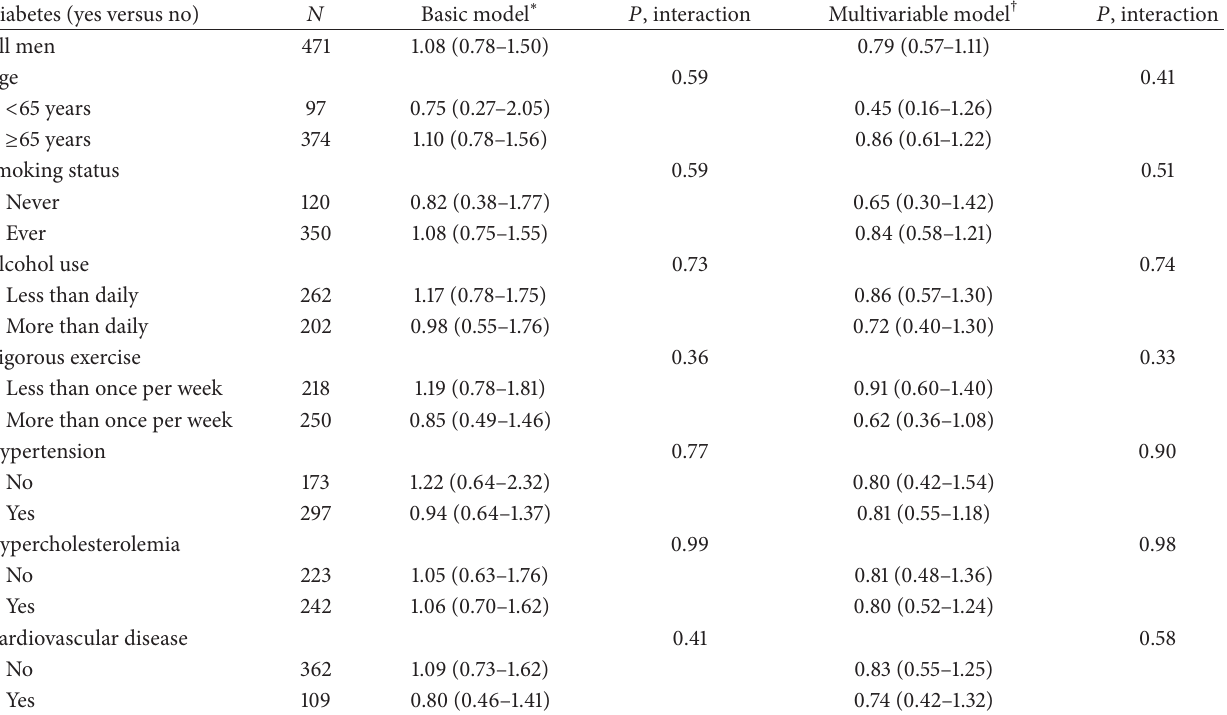
Table 3: Hazard ratio of clinically diagnosed AAA in association with baseline history of diabetes overall and in subgroups. Diabetes (yes versus